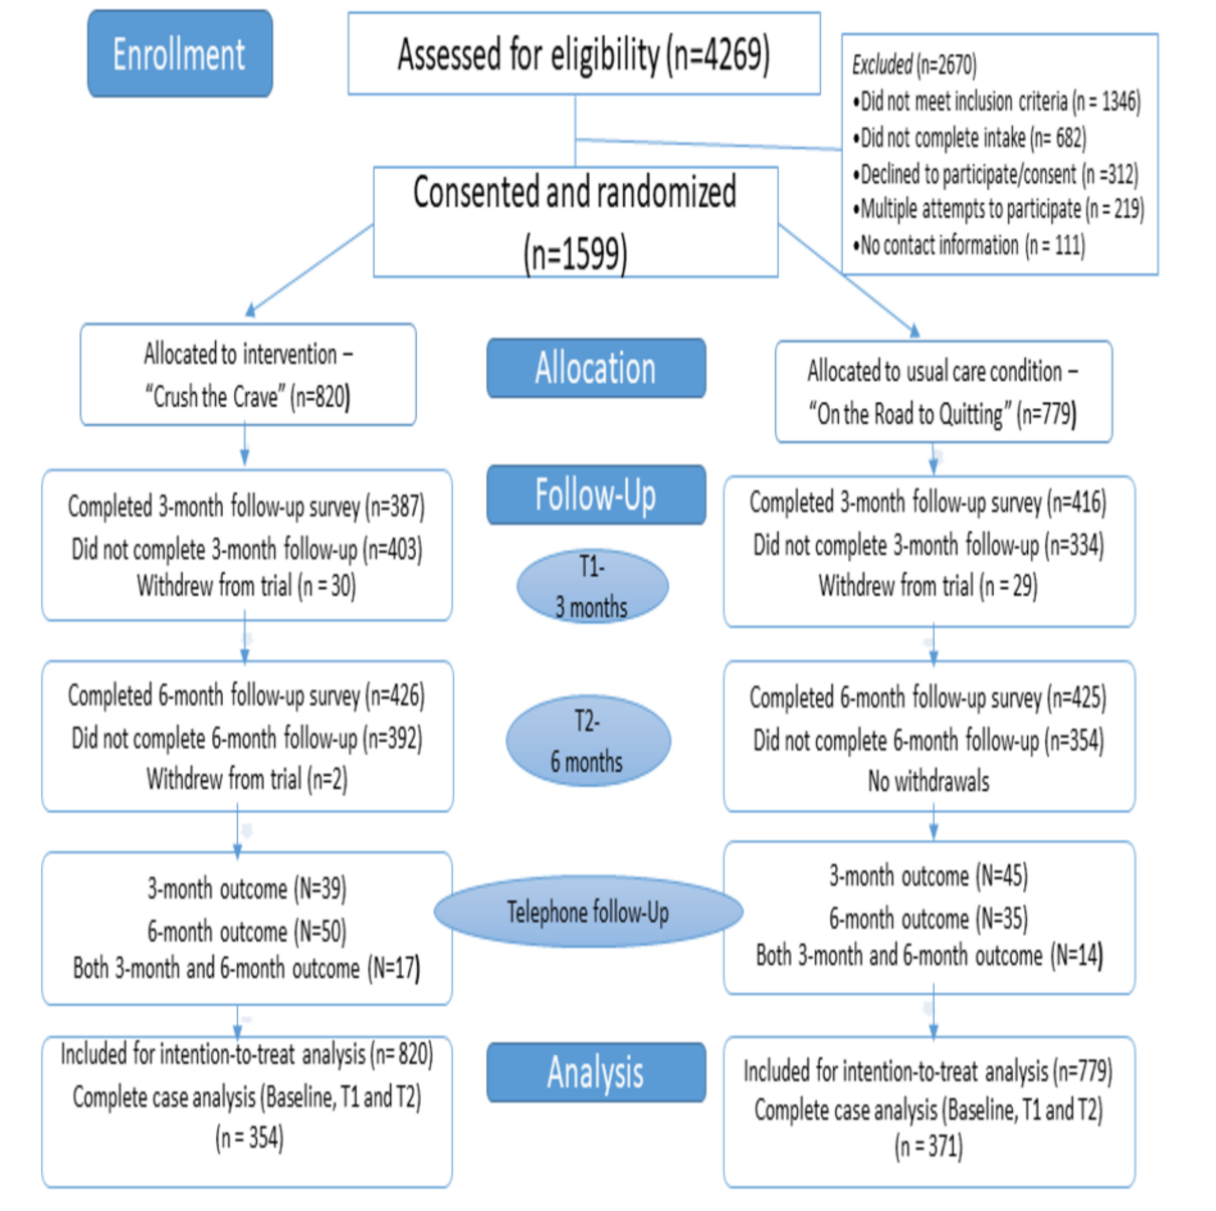
Figure 1. Consolidated Standards of Reporting Trials (CONSORT)-EHEALTH